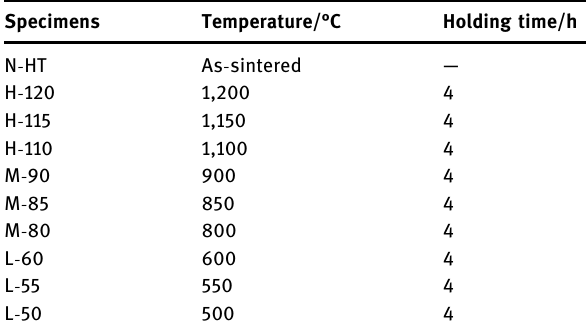
Table 1: The parameters of the annealing process